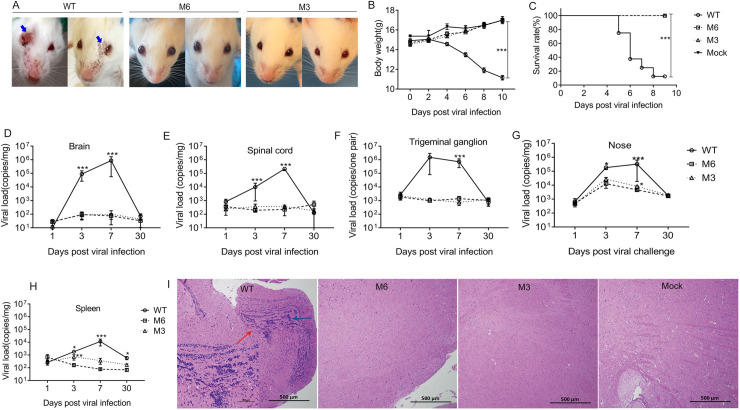
The attenuated phenotype of the M6 strain in mice.(A)Manifestations including ulcerative lesions in the eyes (blue arrow) of infected mice. (B) Weights of mice infected with the WT strain (circle),M6 strain (square) or M3 strain (triangle) or mock infected (PBS, inverted triangle) over a 10-day observation period.(C) Survival curves for the infected mice during the 10-day observation period. Viral loads in the brain (D), spinal cord (E), trigeminal ganglion (F), nose (G) and spleen (H) of mice infected with the WT, M6 or M3 strain, as determined by RT-qPCR. The data are shown as the mean ± SEM based on data from three independent mice. *p< 0.05; **p< 0.01;***p< 0.001. (I) Pathological changes in the cerebrum of mice inoculated with the WT strain, M6 strain, M3 strain or PBS. Tissue sections were stained with hematoxylin and eosin and imaged. Tissue hyperemia and inflammatory cell infiltration detected at 7 d.p.i. are indicated with red and blue arrows, respectively. Scale bars = 500 μm or 100 μm.